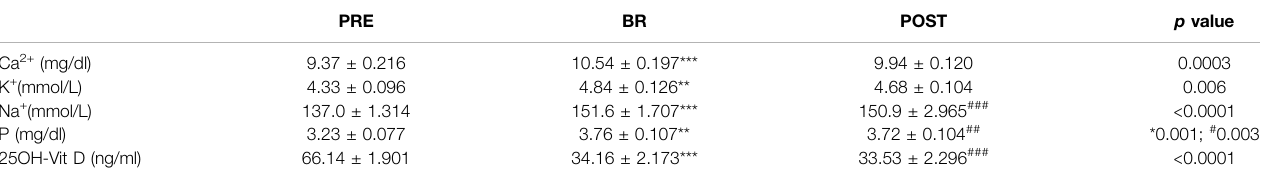
TABLE 1 | Serum Electrolytes and 25OH-Vit D of participants before (PRE), during (BR) and after (POST) 10-day horizontal bed rest. PRE BR POST